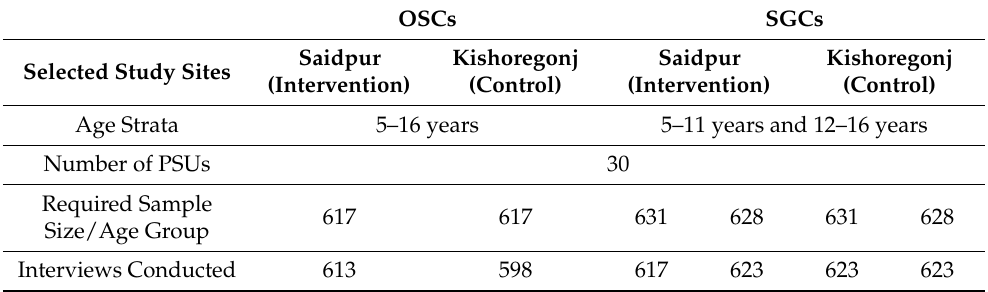
Table 1. Calculated Sample size for the survey.